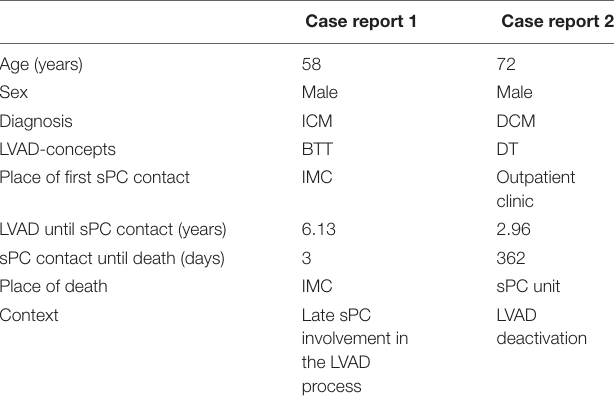
TABLE 2 | Patient characteristics of Case report 1 and